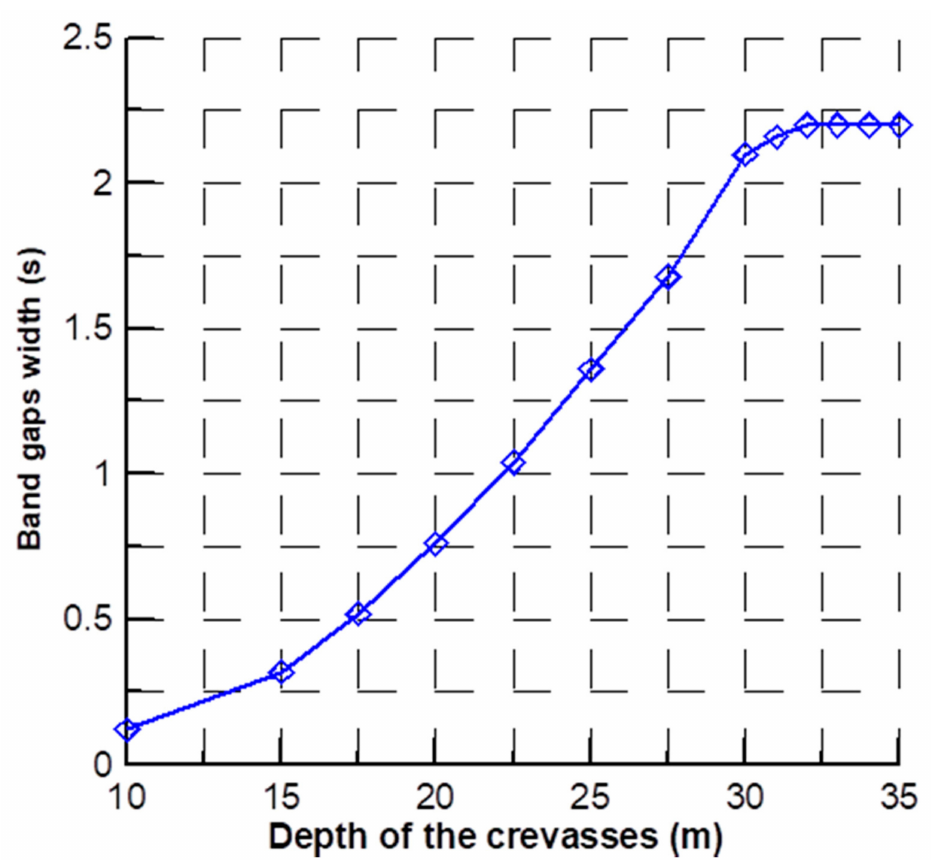
Figure 4. Band-gap width (the “band gap” is shown in (Figure 3)) versus depth of the